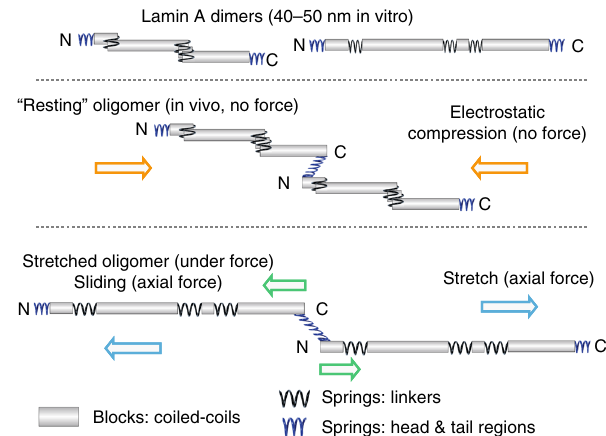
Fig. 10 Model for lamin A compression spring. The lamin A dimer rod can compress to ~ 40 nm by the tandem staggering of coiled coils or be stable in a semi-relaxed state without the stagger at ~ 50 nm (uppermost schematics). In the assembled state disordered regions of the head and tail domains contribute a fl exible connection with the rod at the tetrameric interface that can further compress the polymer in its resting state (middle schematic). Under tension stress these interactions are broken and the fl exible regions can stretch so that they effectively act as springs that enable reversible dimer compression, stretching and sliding in